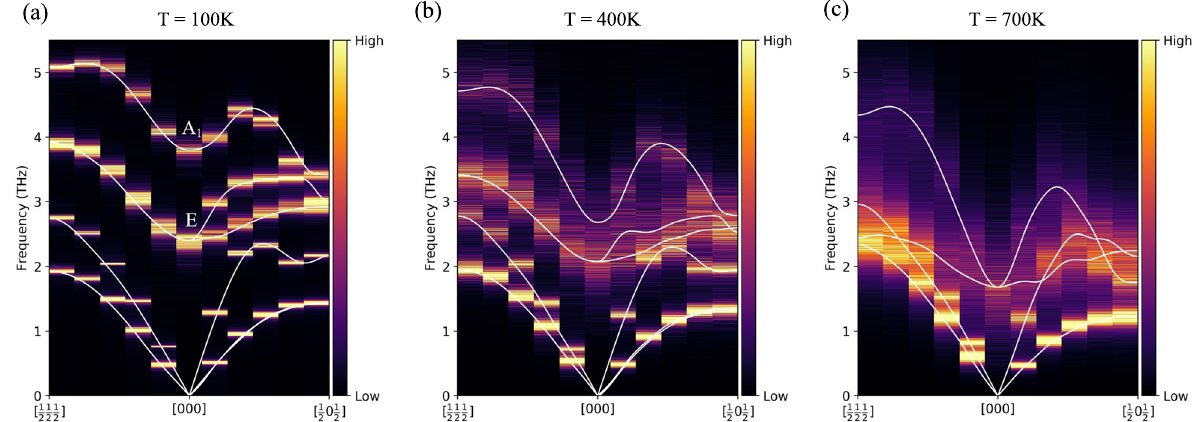
Fig. 3 Temperature dependence of the anharmonic phonon dispersions obtained from MD simulations. The vibrational power spectra of GeTe along with the high-symmetry directions in the fi rst Brillouin zone at ( a ) 100 K, ( b) 400 K, and ( c ) 700 K calculated from MD simulations. The white lines show the renormalized phonon dispersions at the corresponding temperatures. The longitudinal and transverse optical modes at Γ are degenerated due to the removal of long-range electrostatic interactions in MD